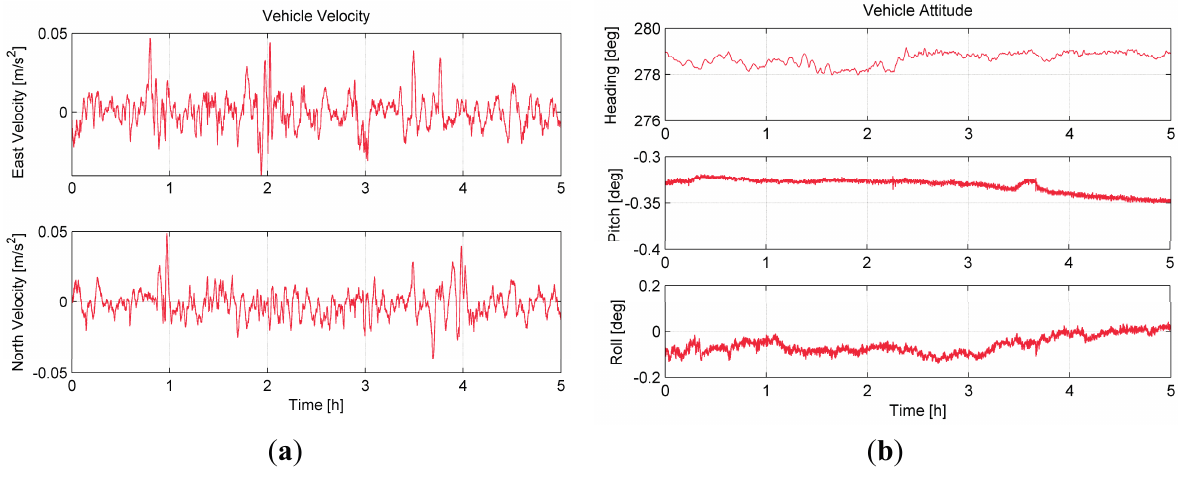
Figure 10. ( a ) The velocity of the vehicle; ( b ) the attitude of the